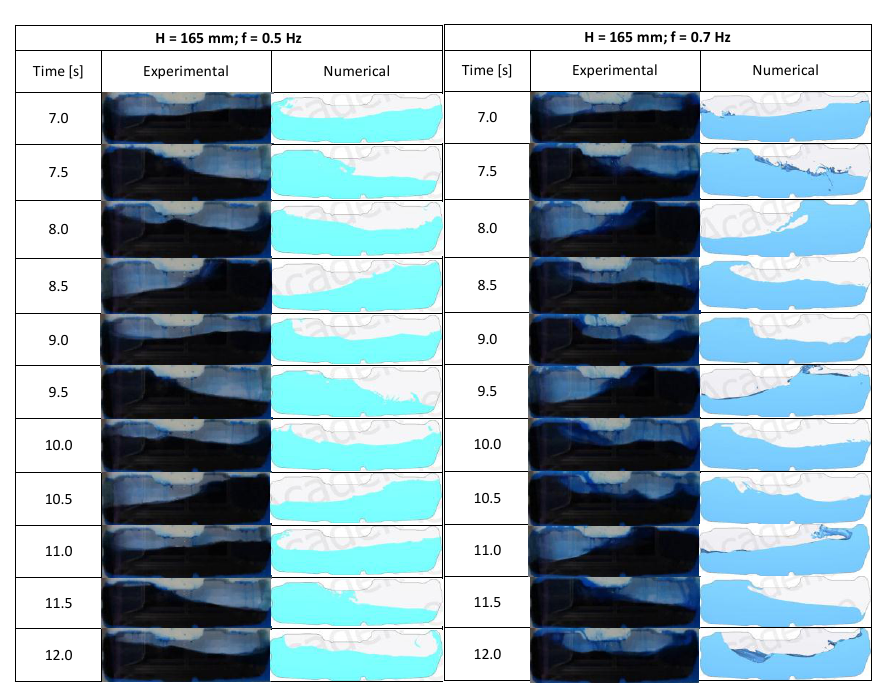
Figure 16. Comparison between numerical and experimental data in the time interval [7 ÷ 12] s for H = 165 mm and frequency values of 0.5 Hz and 0.7 Hz.